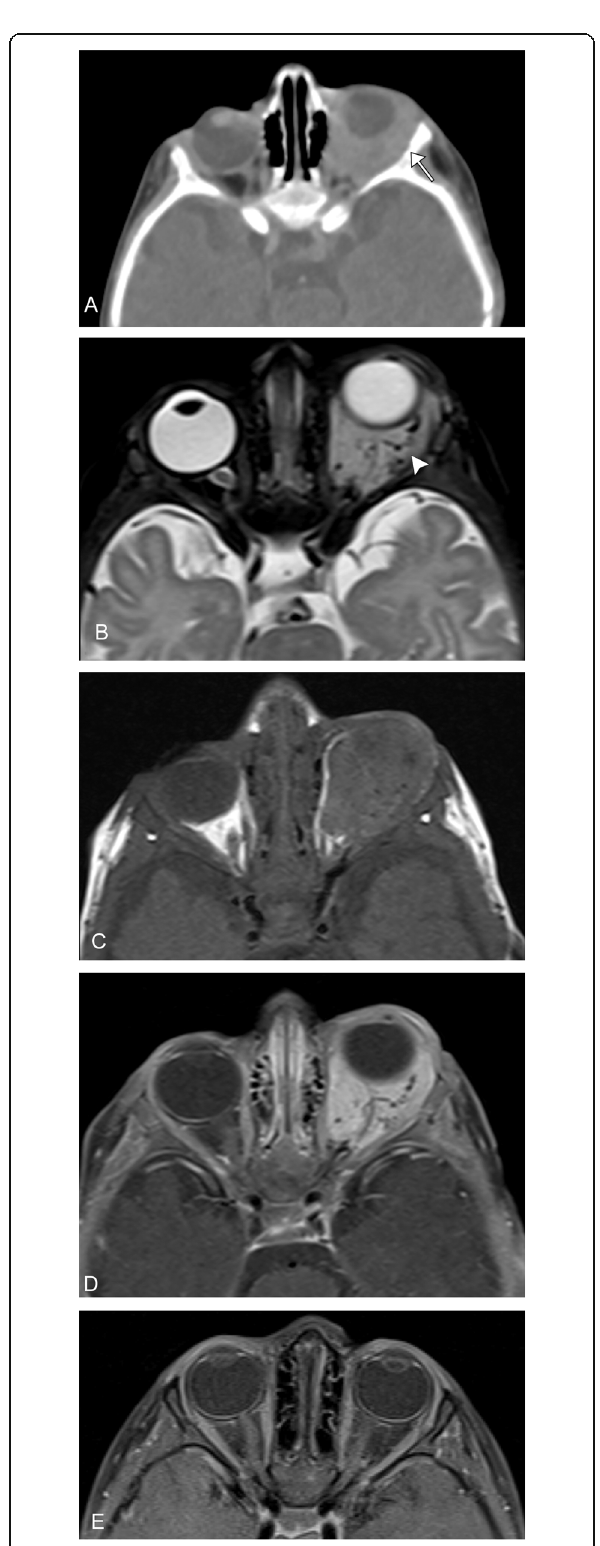
Fig. 1 Infantile hemangioma. A 10-week-old full-term healthy infant presents with 1 week history of gradual swelling of the left eye. a Axial CT with contrast demonstrates an enhancing mass infiltrating the left intraorbital soft tissues, with resultant proptosis and smooth scalloping of the lateral orbital wall (arrow). b Axial T2 image demonstrates a mildly hyperintense mass (note: not as bright as cerebral spinal fluid) with prominent serpiginous vascular flow voids (arrowhead). c Axial T1 pre- and ( d ) post-contrast T1 fat suppressed images demonstrate avid enhancement of the lesion. e The patient was treated with propranol and post-contrast T1 fat suppressed imaging demonstrates resolution of the